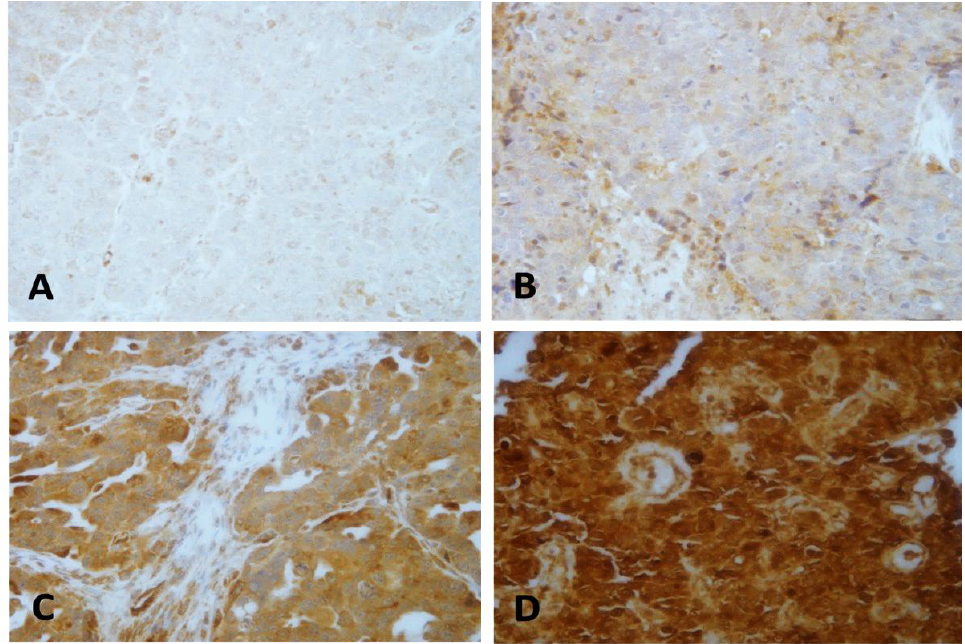
Figure 1. Various levels of cytoplasmic leptin protein expression patterns: ( A ) no (0) expression pattern, ( B ) weak (1+) cytoplasmic expression pattern, ( C ) moderate (2+) cytoplasmic expression pattern, ( D ) strong (3+) cytoplasmic expression pattern of leptin protein. Magnification X40.